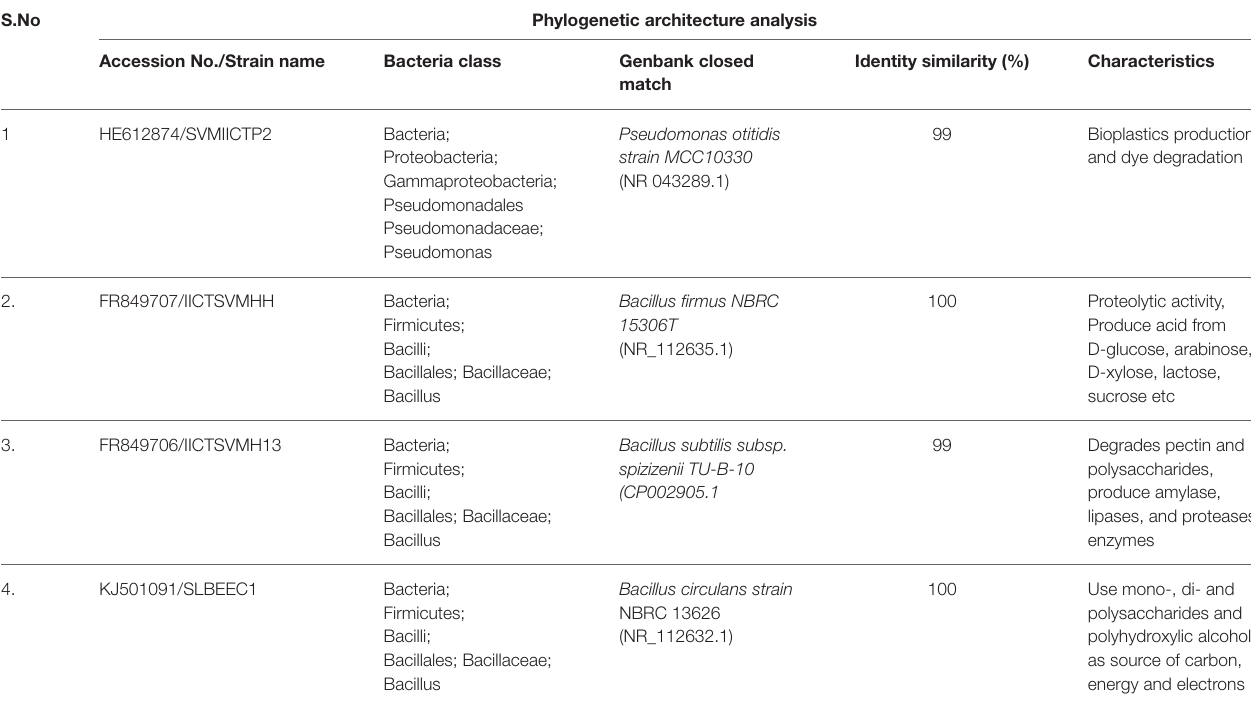
TABLE 1 | List of strains isolated indentified with phylogenetic analysis with accession numbers, classification, GenBank closest match, identity similarities and their properties.